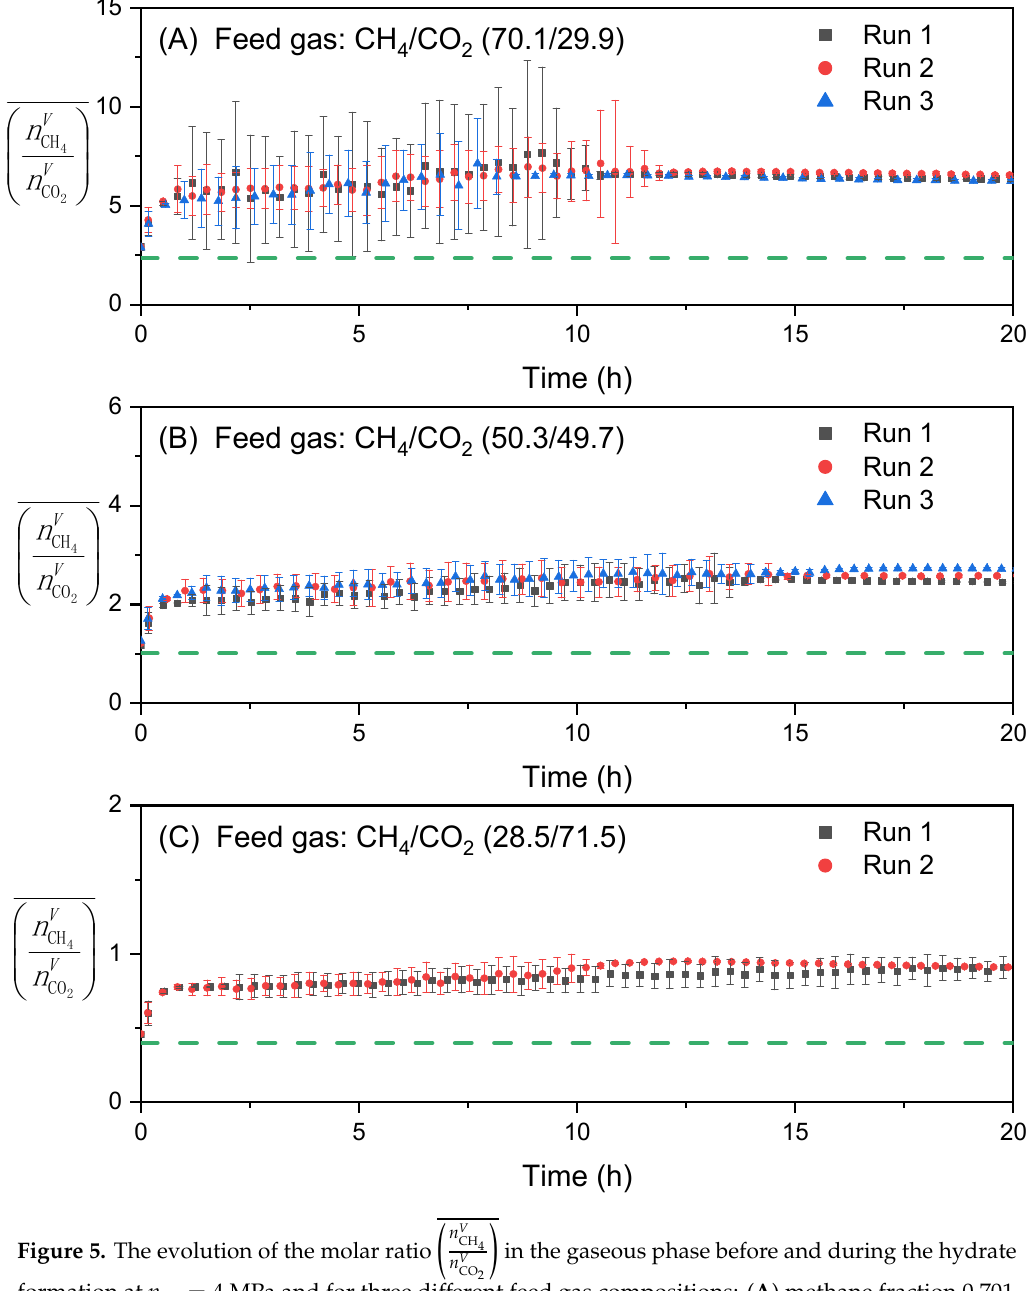
Figure 5. The evolution of the molar ratio in the gaseous phase before and during the hydrate formation at p ini = 4 MPa and for three di ff erent feed gas compositions: ( A ) methane fraction 0.701, ( B ) methane fraction 0.503 and ( C ) methane fraction 0.285. The dashed horizontal lines denote the initial ratio in the feed gas for reference. The colored data points represent mean values that were averaged from 60 subsequently measured values (corresponds to a measurement time of 20 min times 3 spectra per minute). The error bars represent the standard deviation of these 60 measurements. Considering the averaged values together with their standard deviation enables the illustration of several experimental runs in one diagram, as without averaging the diagrams would be overloaded with data points. Each data point train corresponds to one experimental